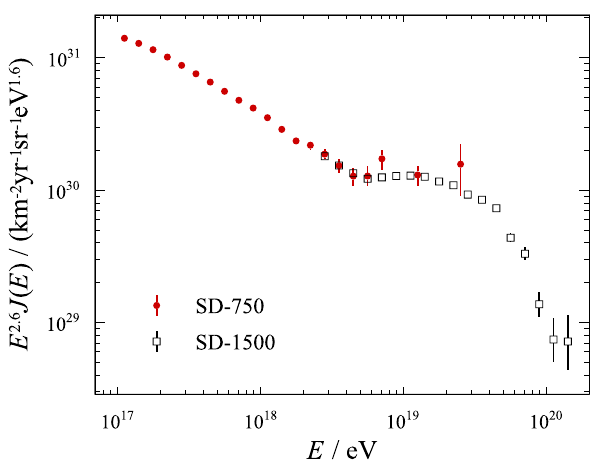
Fig. 16 Superimposed SD spectra to be combined scaled by E 2 . 6 , the SD-750 (red circles) and the SD-1500 (black squares)